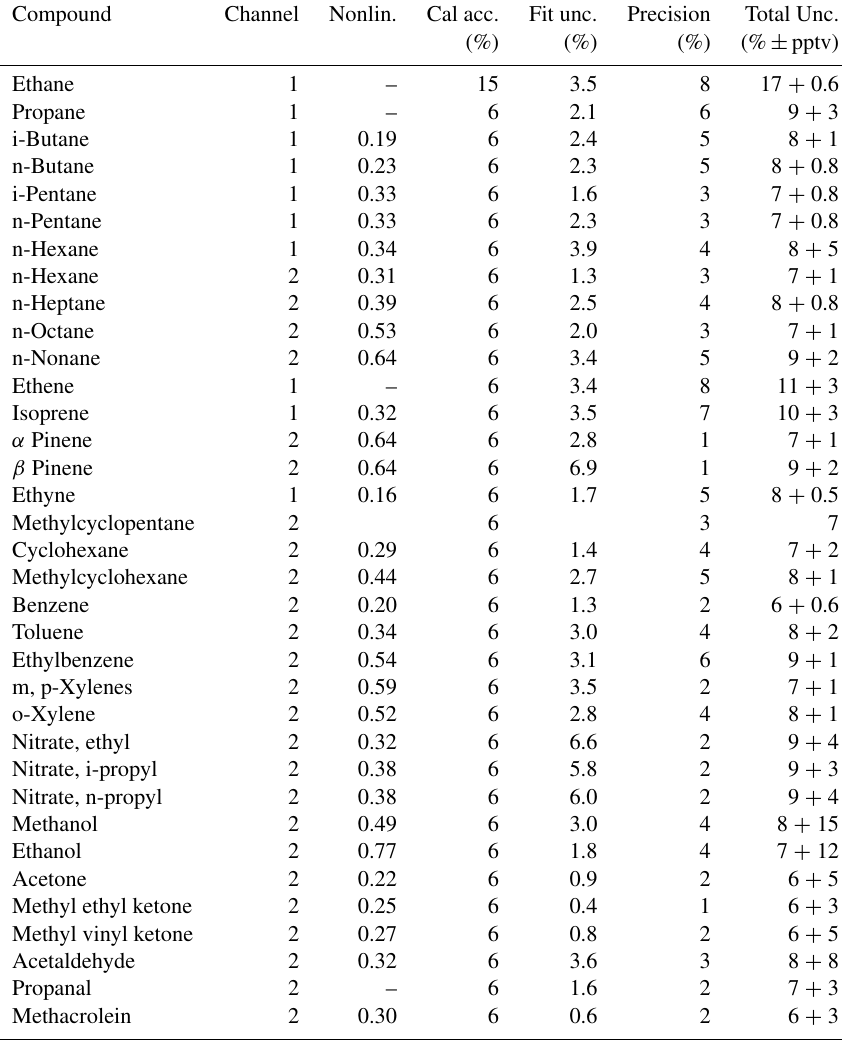
Table 2. VOC species measured by iWAS/ACCBAR during SONGNEX. For each compound, the instrument channel, nonlinearity (Nonlin.; as described in the text, the ratio A:Sens 0 ) , calibration standard accuracy (Cal acc.), calibration fit uncertainty (Fit unc.), precision and total uncertainty (Total Unc.) are